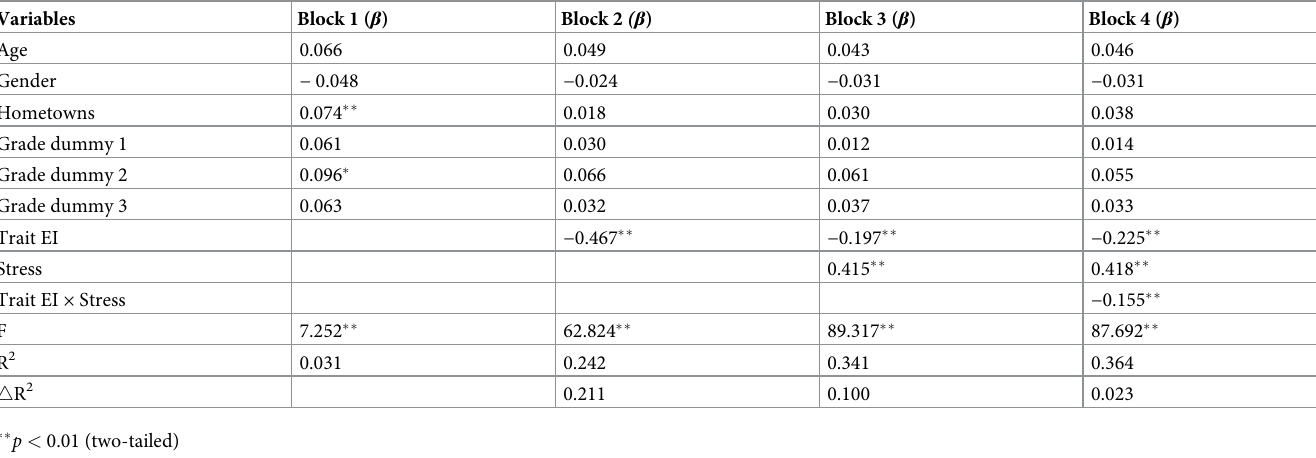
Table 3. Hierarchical linear regression analyses results.